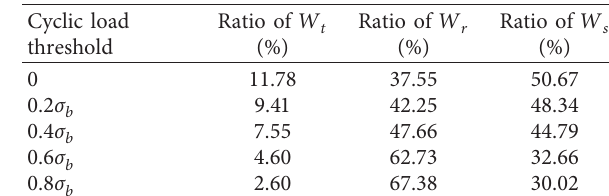
Figure 12: Energy evolution of sandstone with upper limit of cyclic load 0.8 σ b . Table 4: Energy ratio of sandstones with different degrees of damage under impact